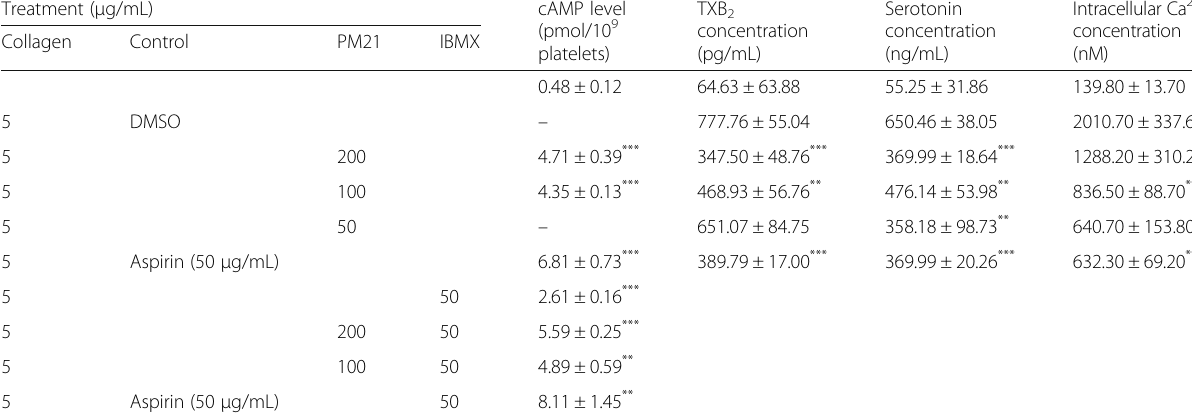
Table 1 Effects of PM21 on cAMP level, TXB 2 formation, serotonin release, and intracellular calcium concentration Treatment ( μ